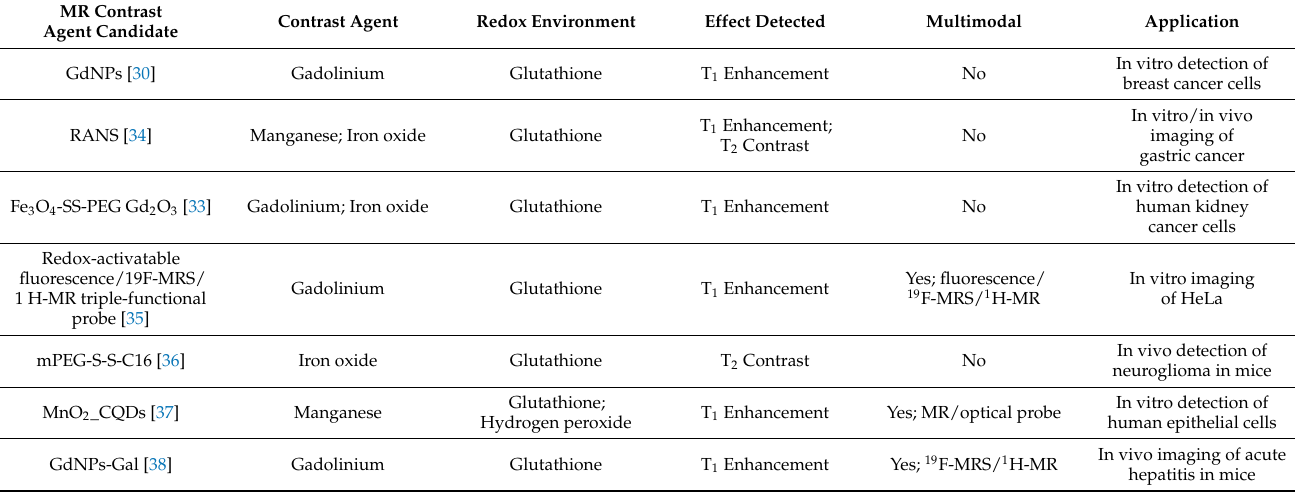
Table 1. Glutathione-sensitive contrast